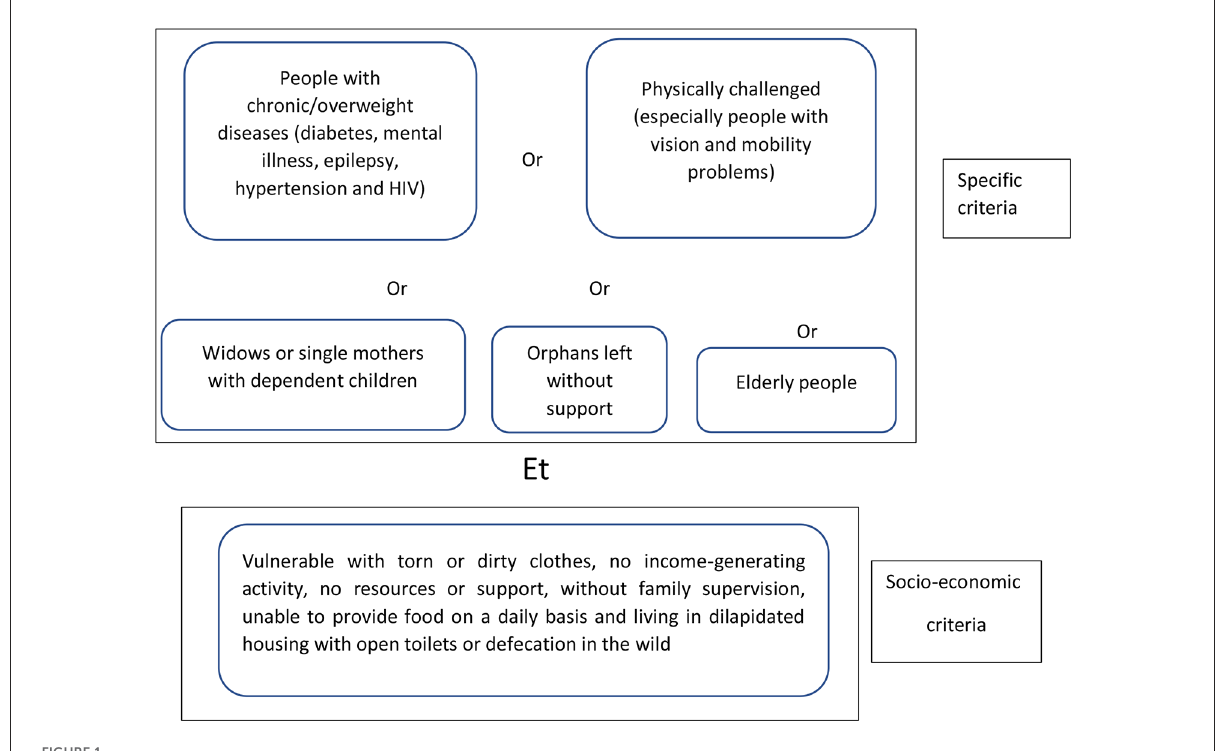
FIGURE1 Active form of indigent identification